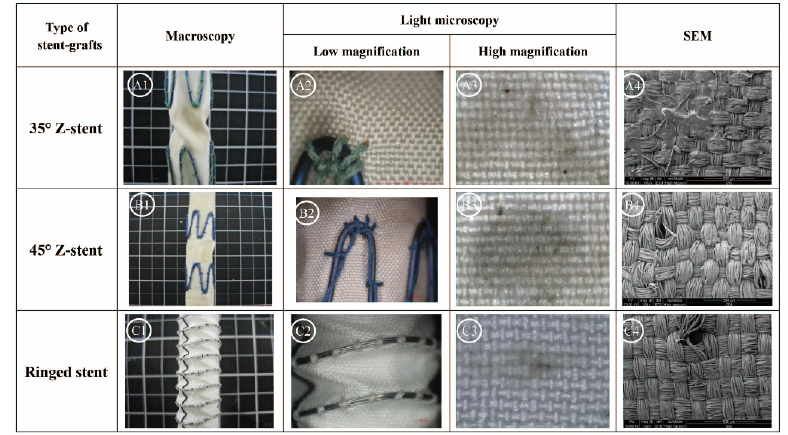
Figure 5. Twist simulations for 24 h. There is no different in damage from fatigue to either Z ‐ stent ‐ graft. Neither stents nor sutures are broken, but the suture holes are enlarged. After the sutures are cut, abrasion is visible at the apex of the 35° stent. The device, stents, and fabric are intact in the ringed stent ‐ graft. ( A1 , B1 , C1 ) Gross observations; ( A2 , B2 , C2 ) Observation in light microscopy with low magnification (10×); ( A3 , B3 , C3 ) Observation in light microscopy with high magnification (40×); ( A4 , B4 , C4 ) Observation in SEM (100×).